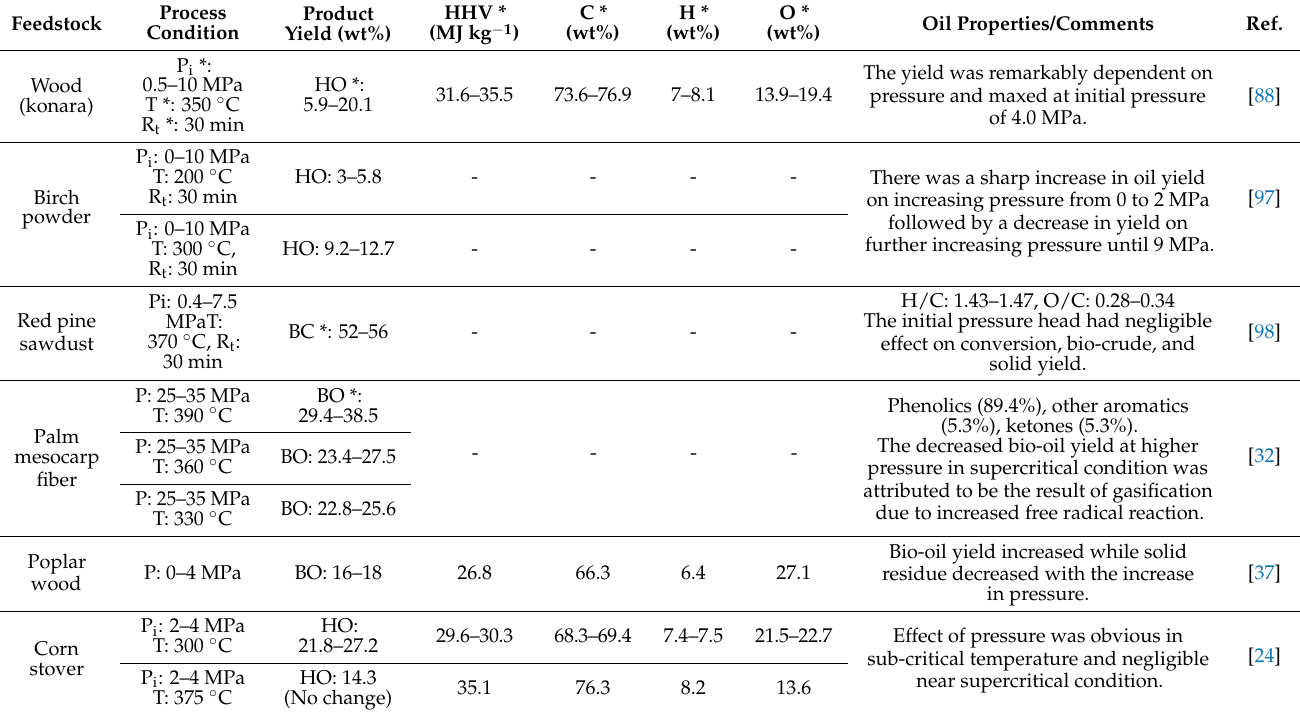
Table 4. Effect of pressure on HTL